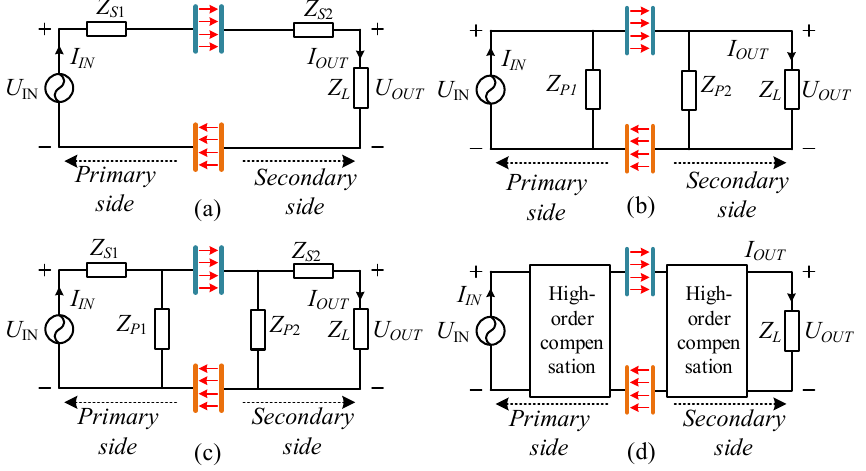
Figure 1. Compensation topologies in the CPT system. ( a ) Series compensation. ( b ) Parallel compensation. ( c ) Series-Parallel compensation. ( d ) High-order compensation.